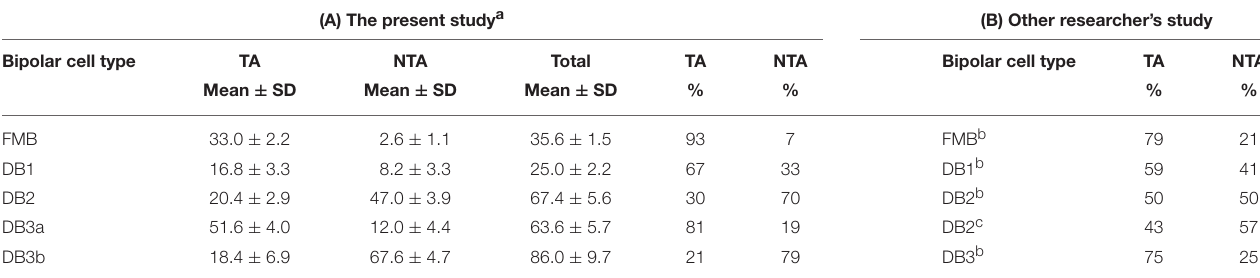
TABLE 1 | Positional configurations of the basal synaptic contacts with cone pedicles for the five types of OFF bipolar cells. (A) The present study a (B) Other researcher’s study Bipolar cell type